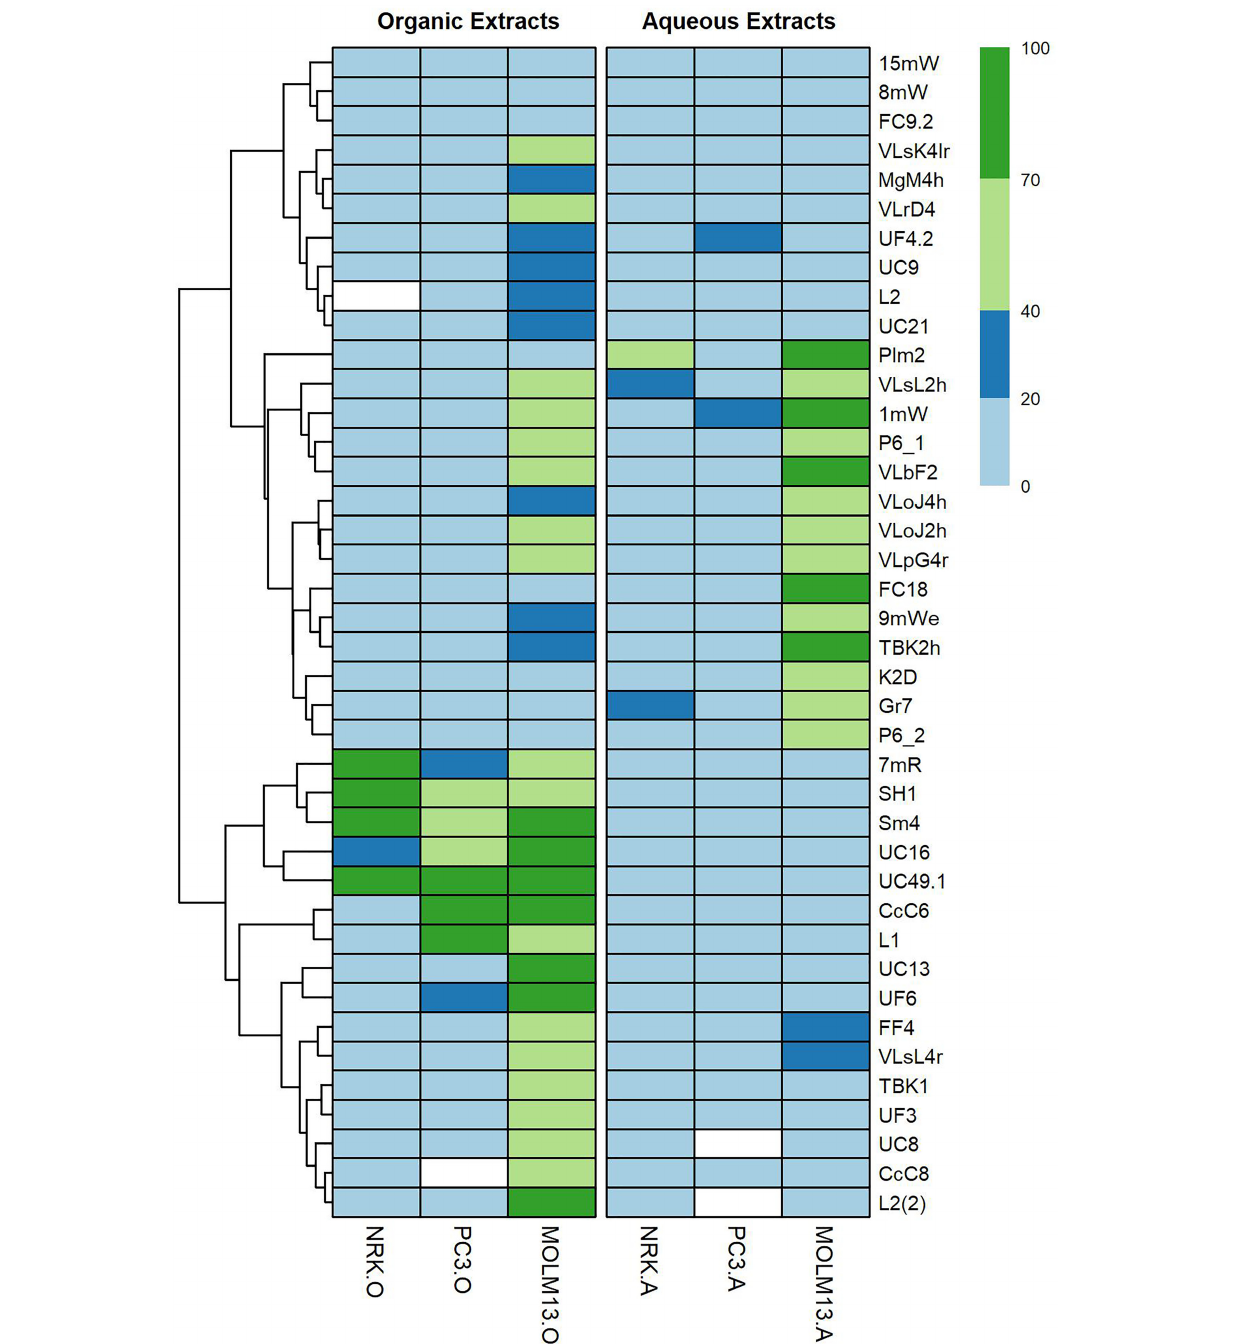
by Prestegard et al. (2009). A minimum of hundred cells from each cell line were used to determine cell death